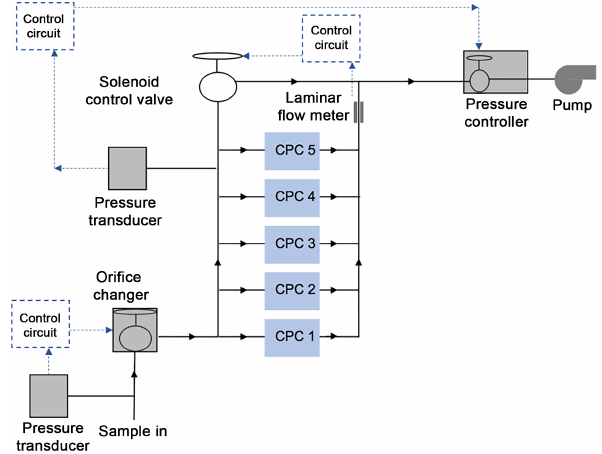
Figure 1. Schematic of the NMASS layout and flow